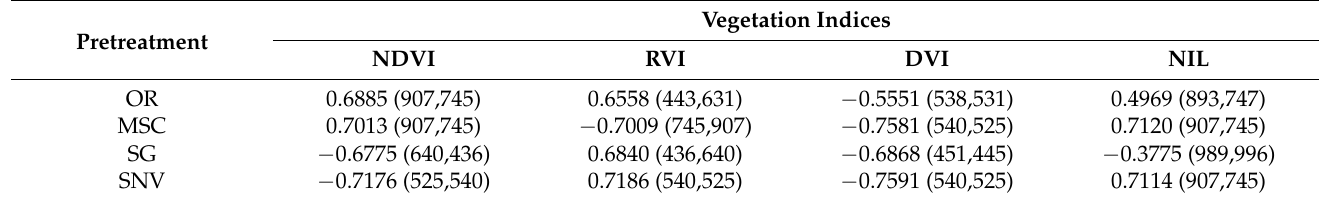
Figure 6. Vegetation index construction based on correlation matrix; different preprocessing spectral reflectance construction vegetation indices: ( a ) OR-NDVI, ( b ) OR-RVI, ( c ) OR-DVI, ( d ) OR-NIL, ( e ) MSC-NDVI, ( f )MSC-RVI, ( g ) MSC-DVI, ( h ) MSC-NIL, ( i ) SG-NDVI, ( j ) SG-RVI, ( k ) SG-DVI, ( l ) Table 5. Correlation and selected bands of optimal vegetation indices after spectral transformation.